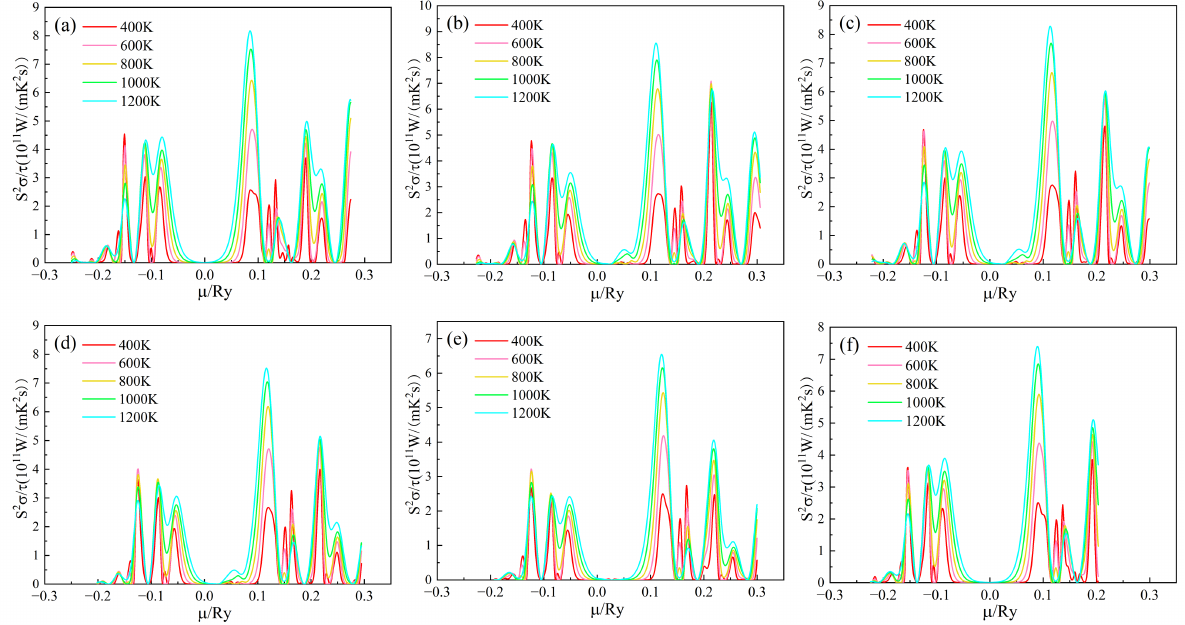
Figure 7. Chemical potential dependent of S 2 σ / τ of (Sr 0.889-x La 0.111 Bi x )TiO 2.963. ( a ) Sr 0.889 La 0.111 TiO 2.963; ( b ) Sr 0.852 La 0.111 Bi 0.037 TiO 2.963; ( c ) Sr 0.815 La 0.111 Bi 0.074 TiO 2.963; ( d ) Sr 0.778 La 0.111 Bi 0.111 TiO 2.963; € Sr 0.741 La 0.111 Bi 0.148 TiO 2.963; ( f ) Sr 0.815 La 0.185 TiO 2.963